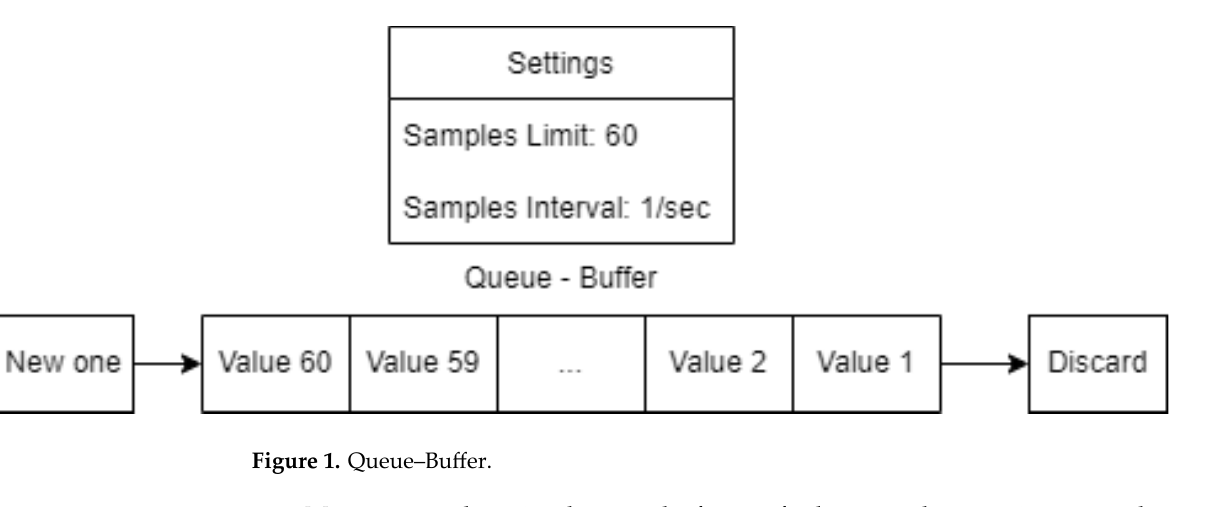
Figure 1. Queue – Buffer. Figure 1.